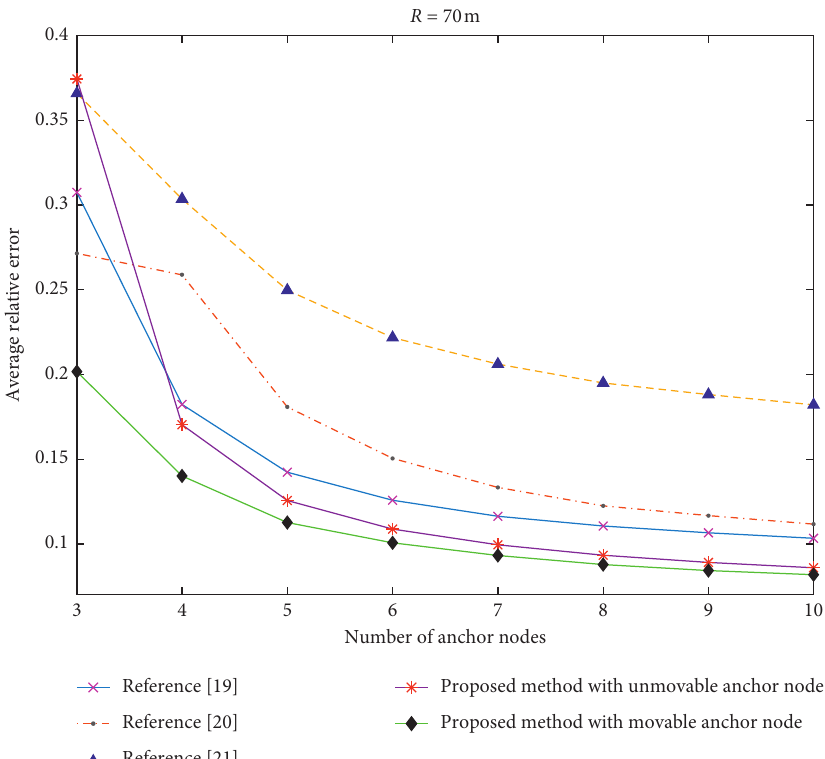
Figure 5: The average relative error with different number of anchor nodes and communication radius 70 meters.